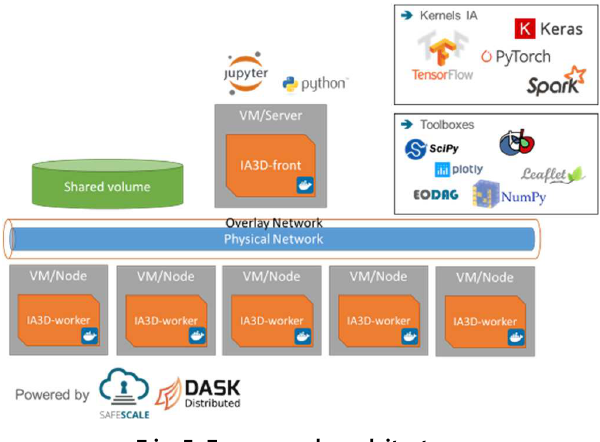
Fig. 5. Framework architecture